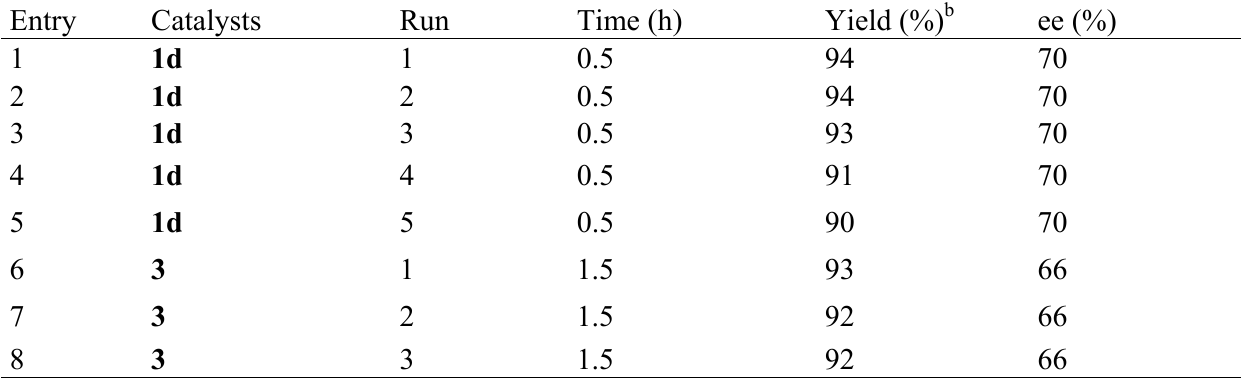
Table 5. Recycling and reuse of catalystic systems in the glyoxylate-ene reaction of 4a with 5a